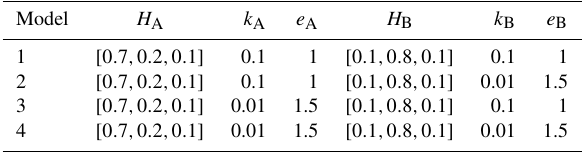
Table 2. Model parameters for the synthetic cases.